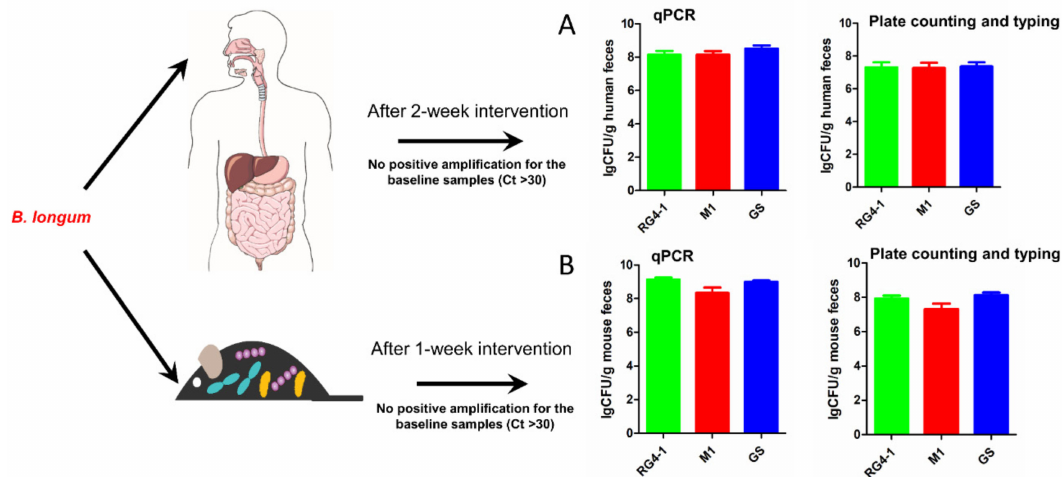
Figure 5. Colonized biomasses of the target B. longum strains in fecal samples from humans and mice. Panel ( A ), the results collected from the human trail; Panel ( B ), the results collected from the animal